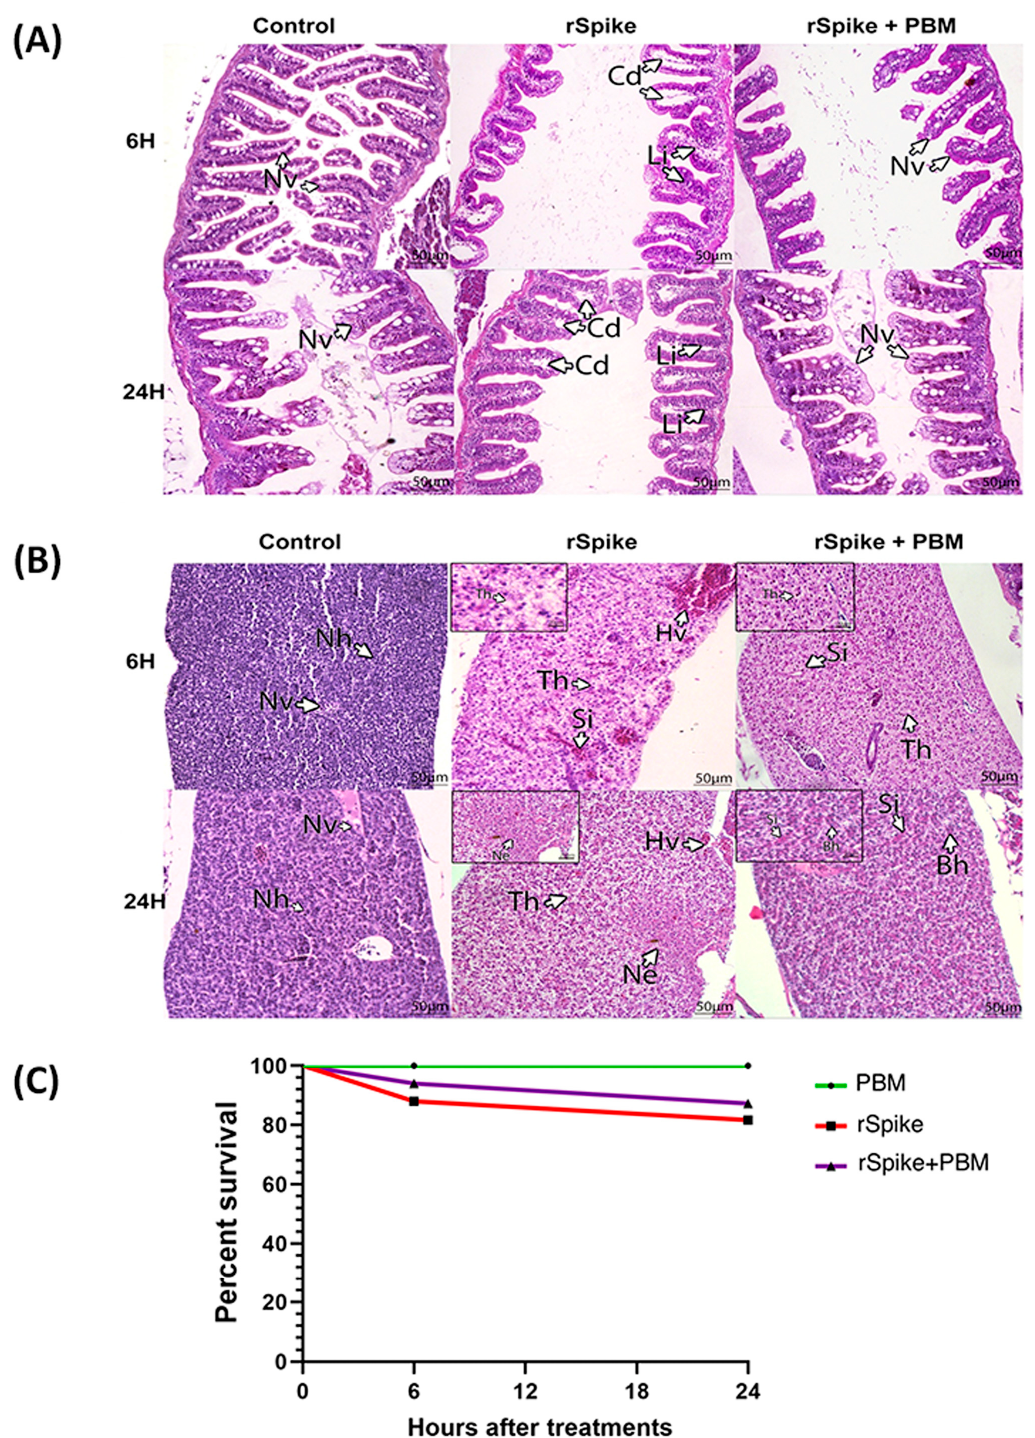
Figure 8. Characterization of acute tissue inflammation induced by rSpike in zebrafish male adults. Histopathological analysis of intestine ( A ) and liver ( B ) of zebrafish injected with recombinant Spike protein (rSpike) and PBM. The evaluations occurred after 6 and 24 h. All sections were stained with Hematoxylin and Eosin. Scale: 40 µ m. Arrows indicate Nv: Normal villi; Cd: dilated vasa chylifer; Li: lymphocytes, Nh: normal hepatocytes; Hv: hyperemia of vessels; Th: turgid hepatocytes; Si: sinusoids; Ne: necrosis; Bh: basophil hepatocytes. ( C ) Cumulative Kaplan–Meier probability curve indicating the survival rate of zebrafish males submitted to different treatments: PBM (control), injected with recombinant Spike protein (rSpike), and (rSpike + PBM).